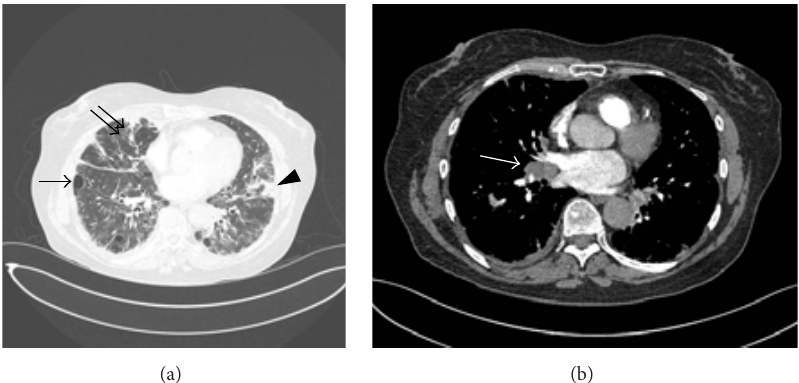
Figure 1: (a) Computed tomography scan of the chest, showing widespread pulmonary changes, including multiple thin-walled cystic air spaces (single arrow), scattered foci of consolidation (arrowhead), and interlobular septal thickening (double arrow). Radiologic findings were most suggestive of lymphoid interstitial pneumonia, but lymphoma could not be excluded. (b) Computed tomography scan of the chest demonstrating enlarged hilar